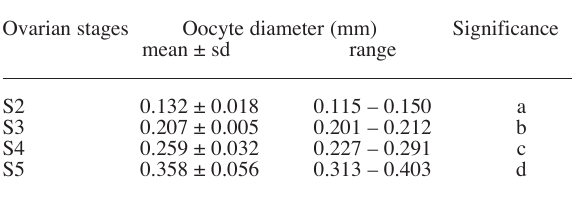
T ABLE 1. – Chasmagnathus granulatus . Oocyte size and ovarian stages (S2-S5) in MC; n=30 oocytes per stage, oocytes were not detected in S1. Different letters indicate significant differences (one-way ANOVA and SNK test; p < 0.0001). Ovarian stages Oocyte diameter (mm) Significance mean ± sd